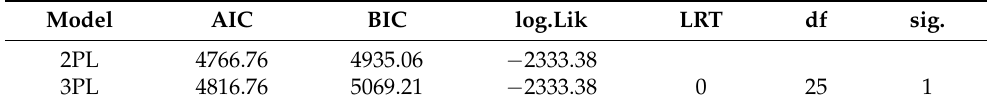
Table 4. Model comparison: 2PL and 3PL.